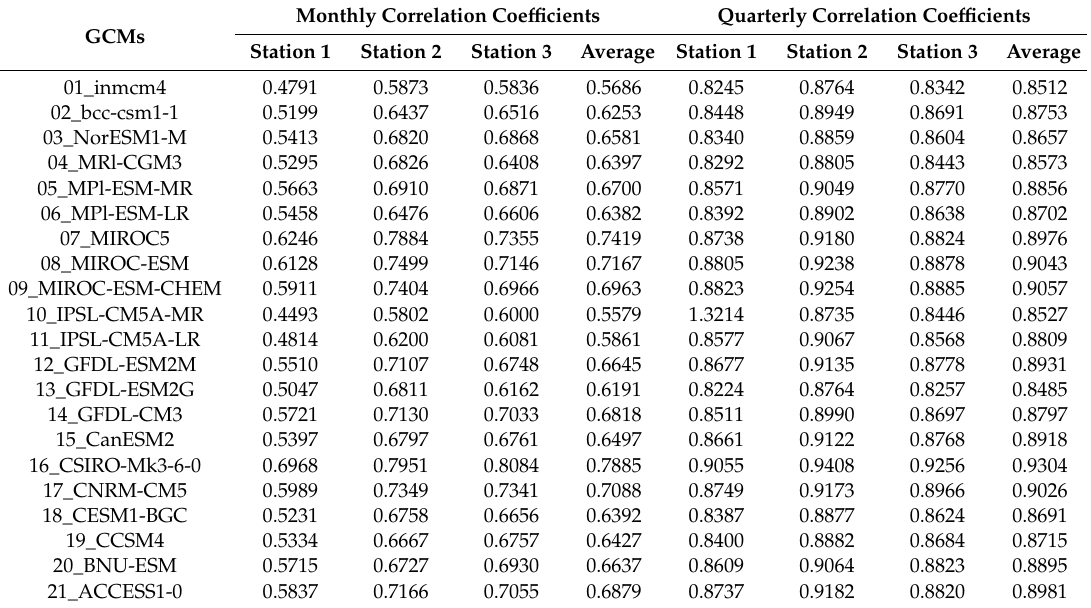
Table 1. Monthly and quarterly correlation coe ffi cients for the 21 Global Climate Models for the period between 1986 and 2005